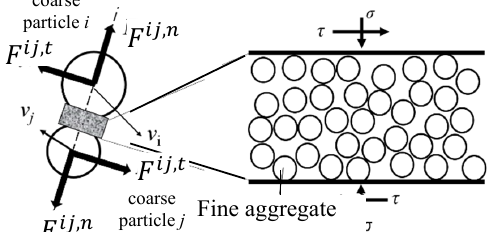
Fine Fig. 4. Sketches illustrating the use of the fine particle-fluid mixture for the viscosities in Eqns. (3)-(4).